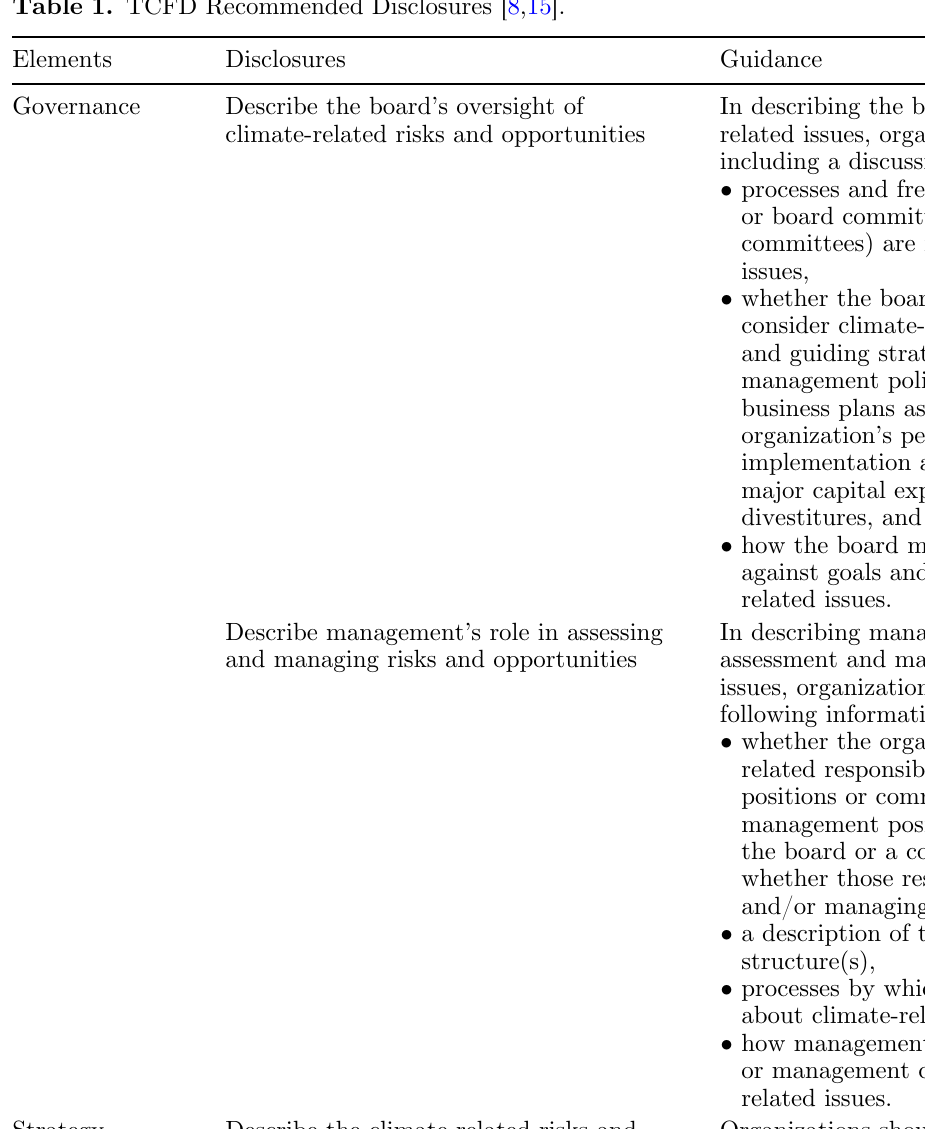
Table 1. TCFD Recommended Disclosures